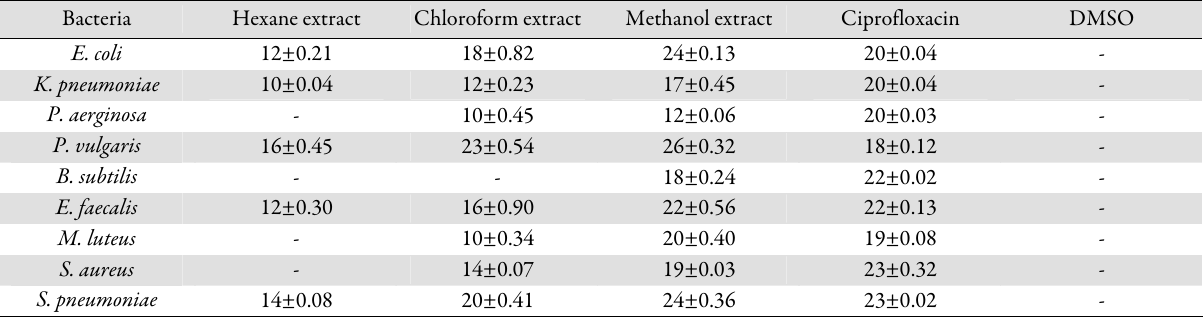
Tab. 1. Antimicrobial activity of extracts of L. acidissima